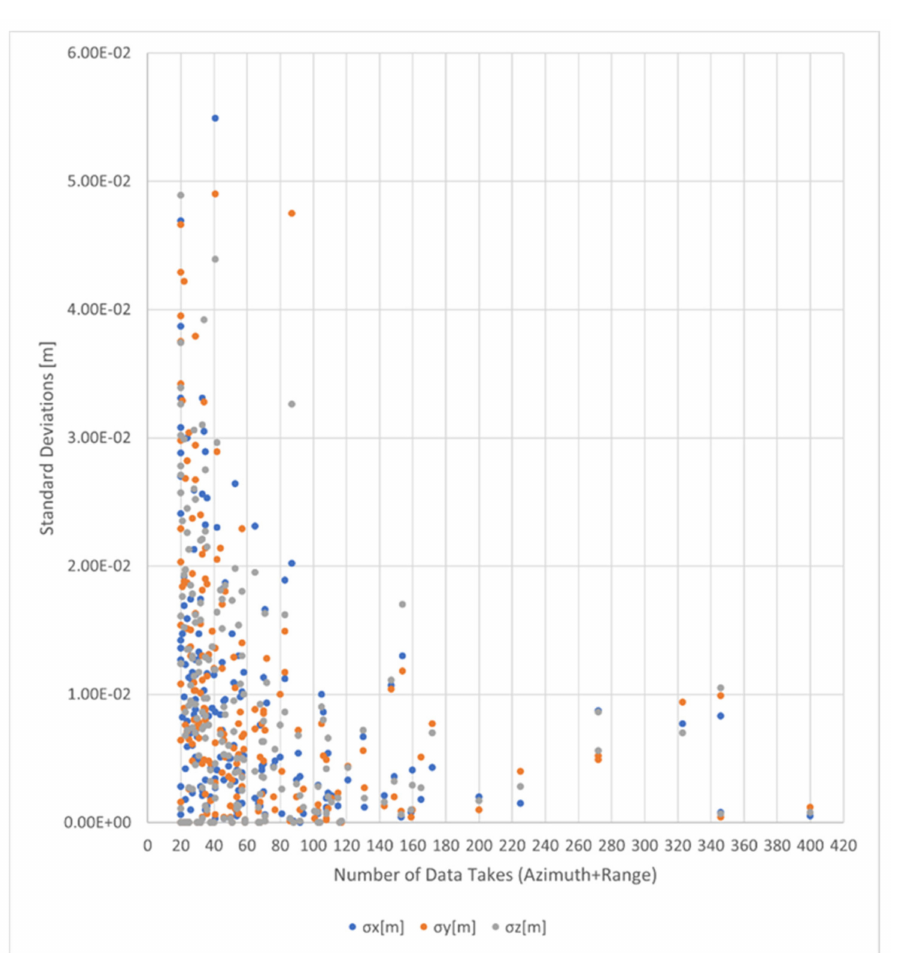
Figure 7. Standard Deviations of absolute positioning of all ECRs and all temporal resolutions (1 M, 2 M, 3 M, 4 M, yearly) per number of data takes (sum of range and azimuth